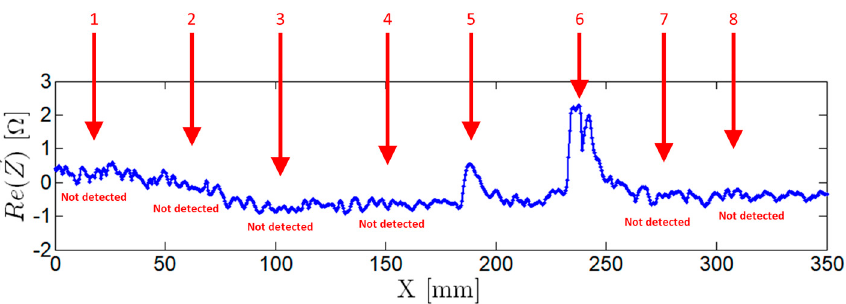
Figure 14. Commercial EC probe output signal operating at a frequency of 750 kHz. Defects 1 to 8 as presented in Table 1.